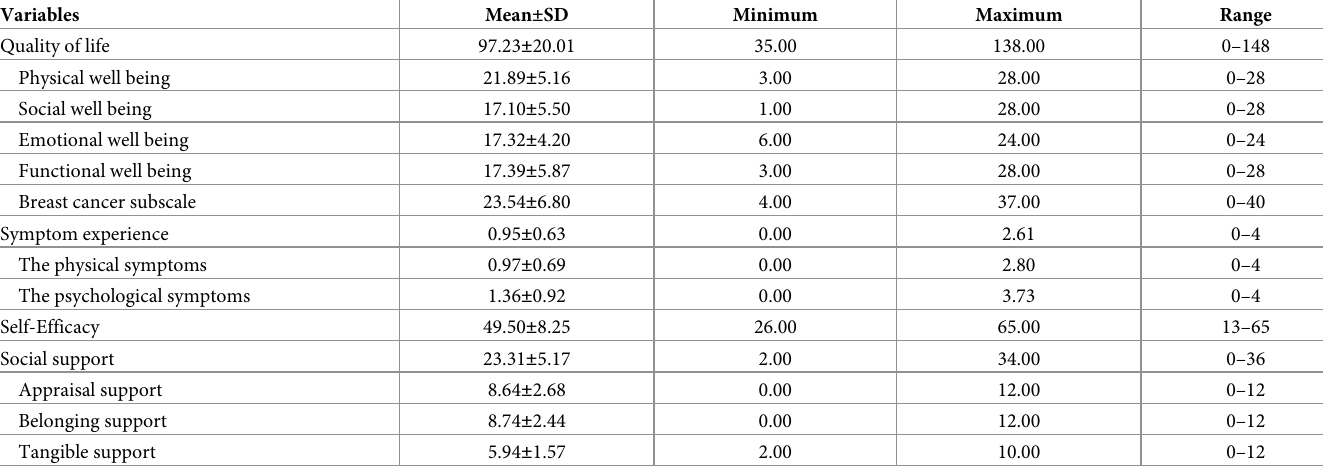
Table 2. Descriptive statistics of quality of life, symptom experience, self-efficacy, and social support of the study participants (N = 140).